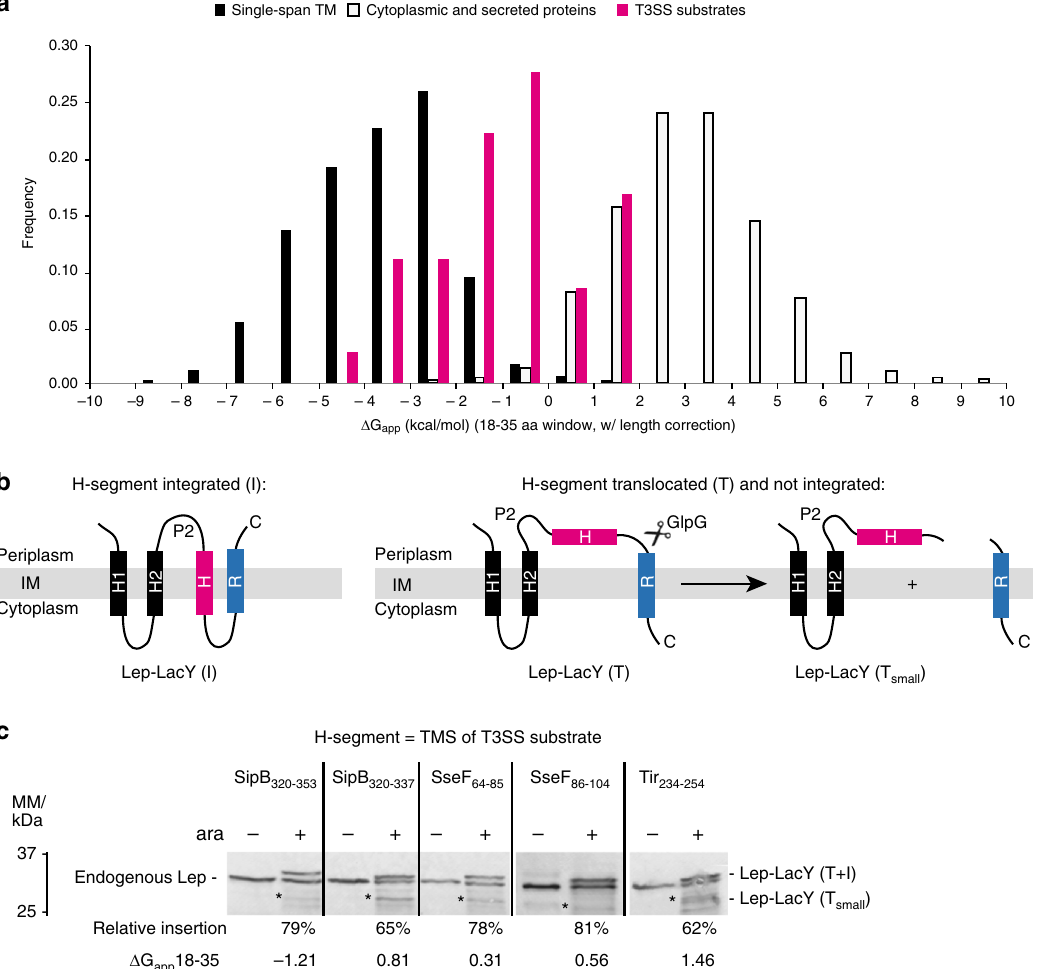
Fig. 2 Prediction and experimental validation of membrane integration of TMS of T3SS substrates a Distribution of the calculated membrane integration propensity ( Δ G app ) of TMS of T3SS substrates (red) compared to previously published values for Δ G app of regular transmembrane- and soluble proteins, respectively 20 . For each protein, only its lowest Δ G app of any given sequence window is shown ( Δ G predictor settings: window size: 18 – 35 aa, length correction: ON). b Principle of the TMS insertion assay, see results and methods sections for description 21 . c Relative membrane insertion of the indicated TMS was analyzed in E. coli BW25113 with the TMS insertion assay. ± ara indicates induction of expression of the respective test construct. The fate of the Lep-LacY chimera was assessed by SDS PAGE, Western blotting and immunodetection of the Lep P2 domain. A representative result of three independent experiments is shown. The fraction of inserted Lep-LacY (f I ) was calculated from the ratio of uncleaved to cleaved (indicated by asterisk) Lep-LacY, corrected for different degradation rates of the individual fragments according to Öjemalm et al 21 .. Abbreviations: ara: arabinose; Lep: leader peptidase; Lep-LacY (T + I): translocated and integrated membrane helix; Lep-LacY (T small ): small translocated form of Lep-LacY. IM inner membrane,